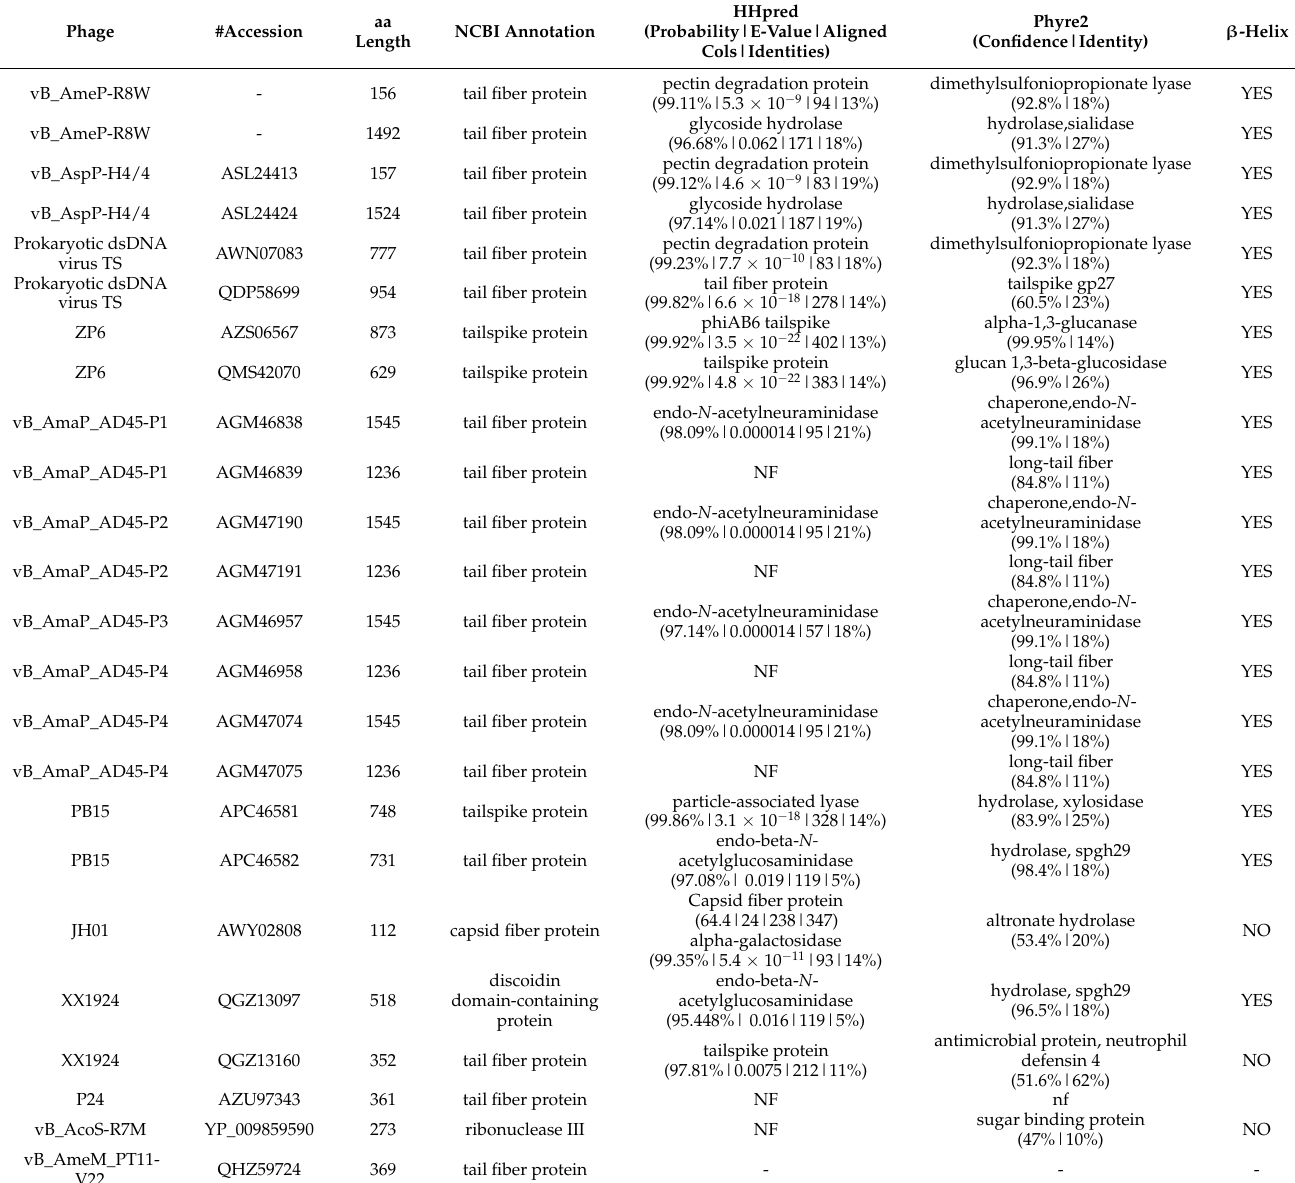
Table 3. RBPs of